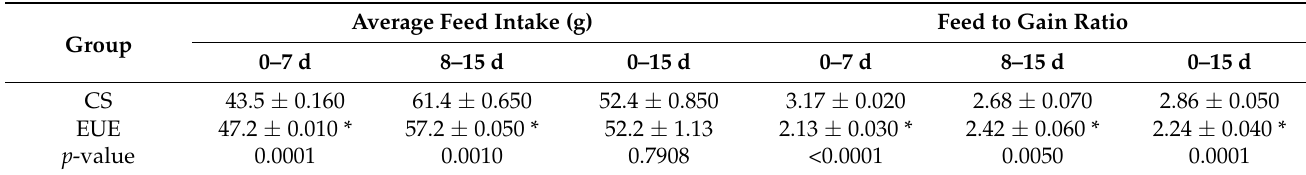
Table 5. The AFI and F/G of chicks under cold stress.